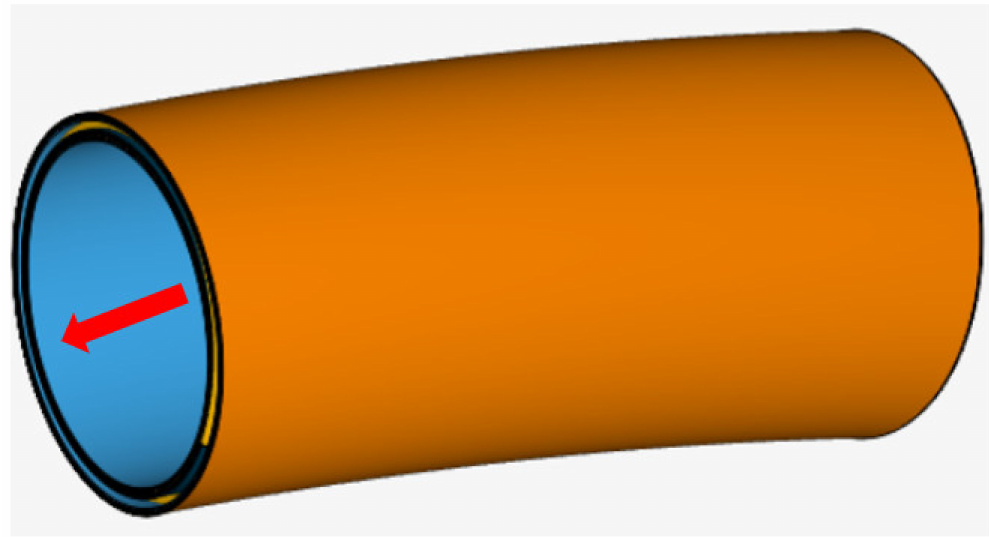
Figure 7. Internal pressure load applied on the offshore hose in Simscale